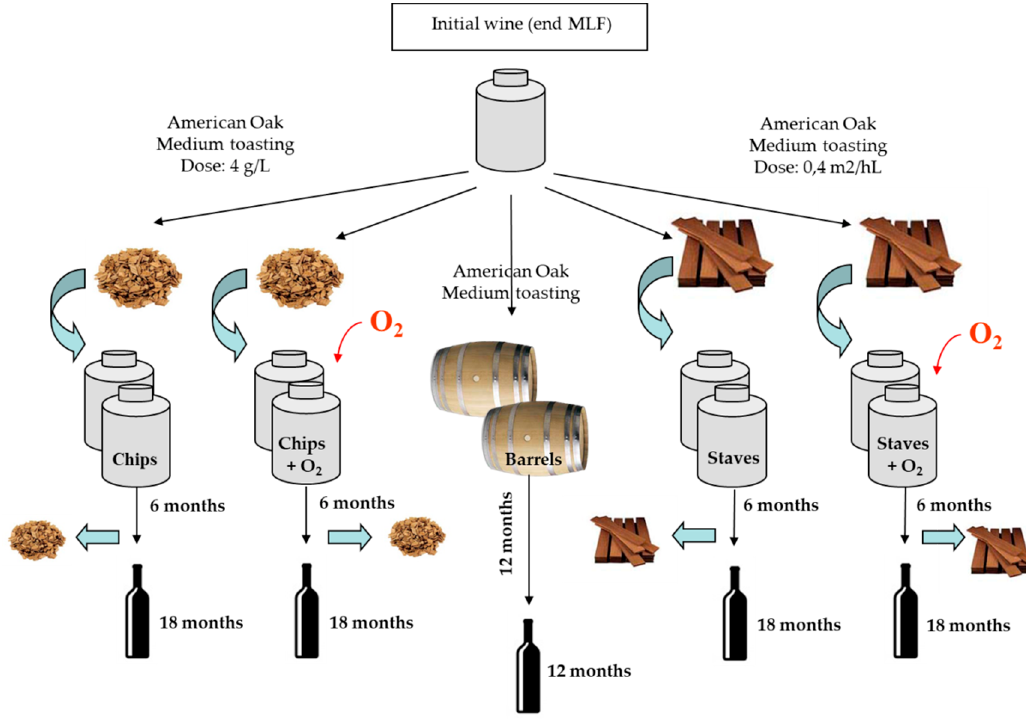
Figure 1. Experimental design.